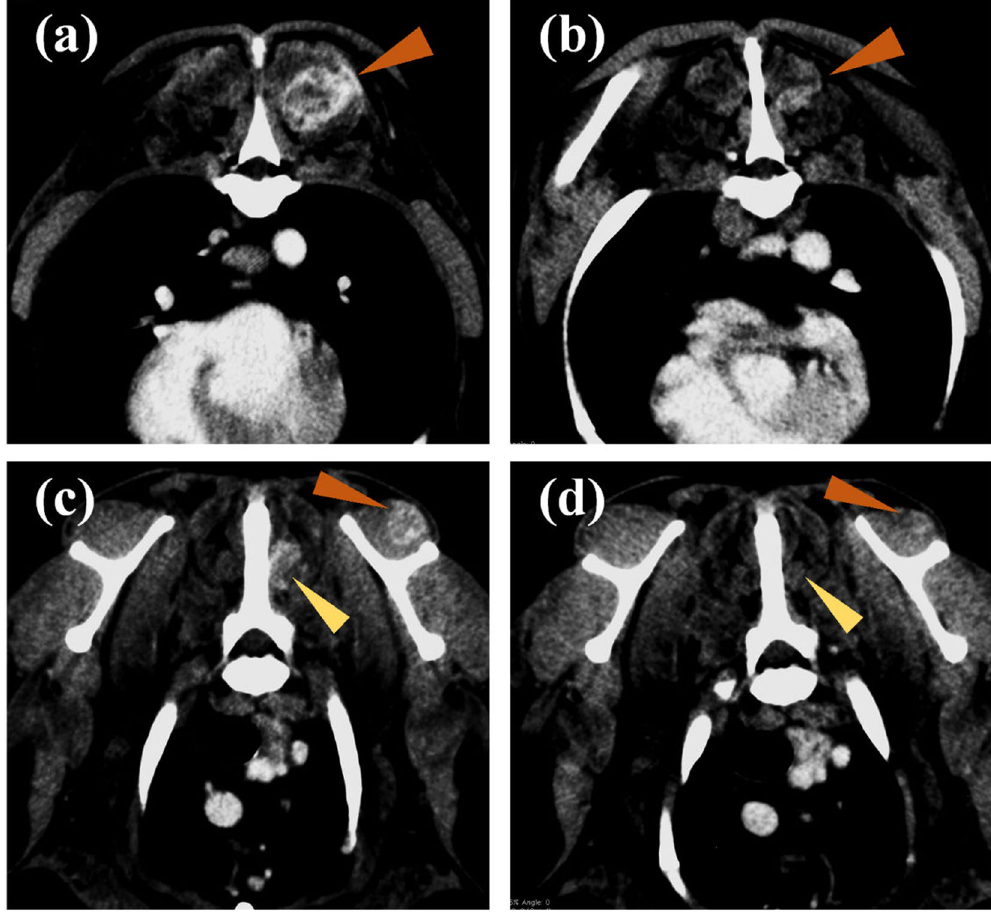
Figure 4. Antitumour effect of c4G12 in a dog with undifferentiated sarcoma. A dog with multiple metastatic lesions of undifferentiated sarcoma was treated with 5 mg/kg c4G12 every 2 weeks and the tumour burden was evaluated by computed tomography (CT). ( a , c ) Tumour appearance at baseline (week 0). ( b , d ) Tumour appearance after 3 weeks of c4G12 treatment. The tumours clearly responded to treatment on week 2, and the shrinkage was confirmed by CT on week 3. Contrast-enhanced, and matched transverse CT images were shown. Arrowheads indicate the tumour lesions.